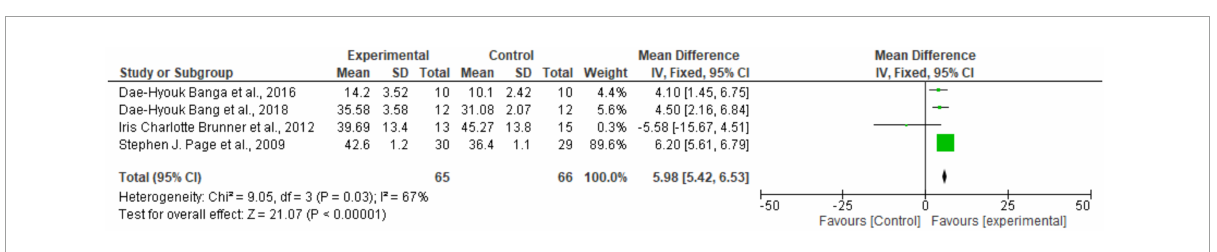
FIGURE4 Forest Plot of the manual function assessed by the Action Research Arm Test. SD, standard deviation; CI, confidence interval.